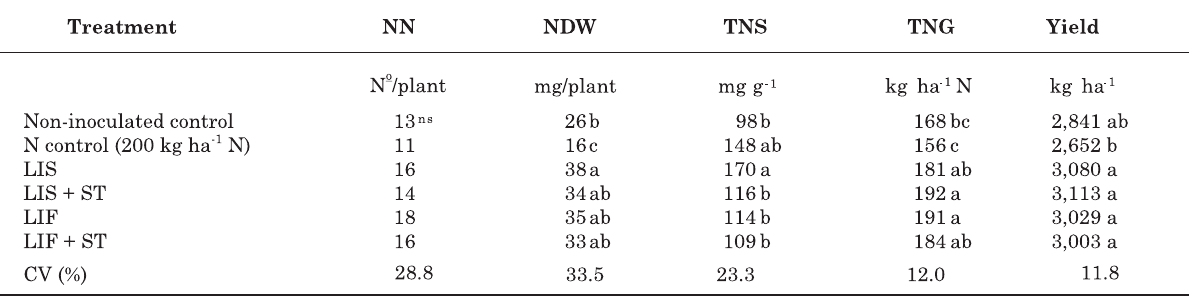
(1) Inoculant concentration to deliver 300,000 cells seed -1 . Fungicides and micronutrients are described in the Materials and Methods section. (2) Means (n = 6) in the same column followed by different letters are significantly different (p ≤ 0.05, Fisher LSD